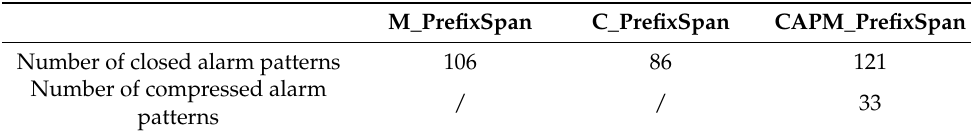
Table 7. The number of extracted alarm patterns.